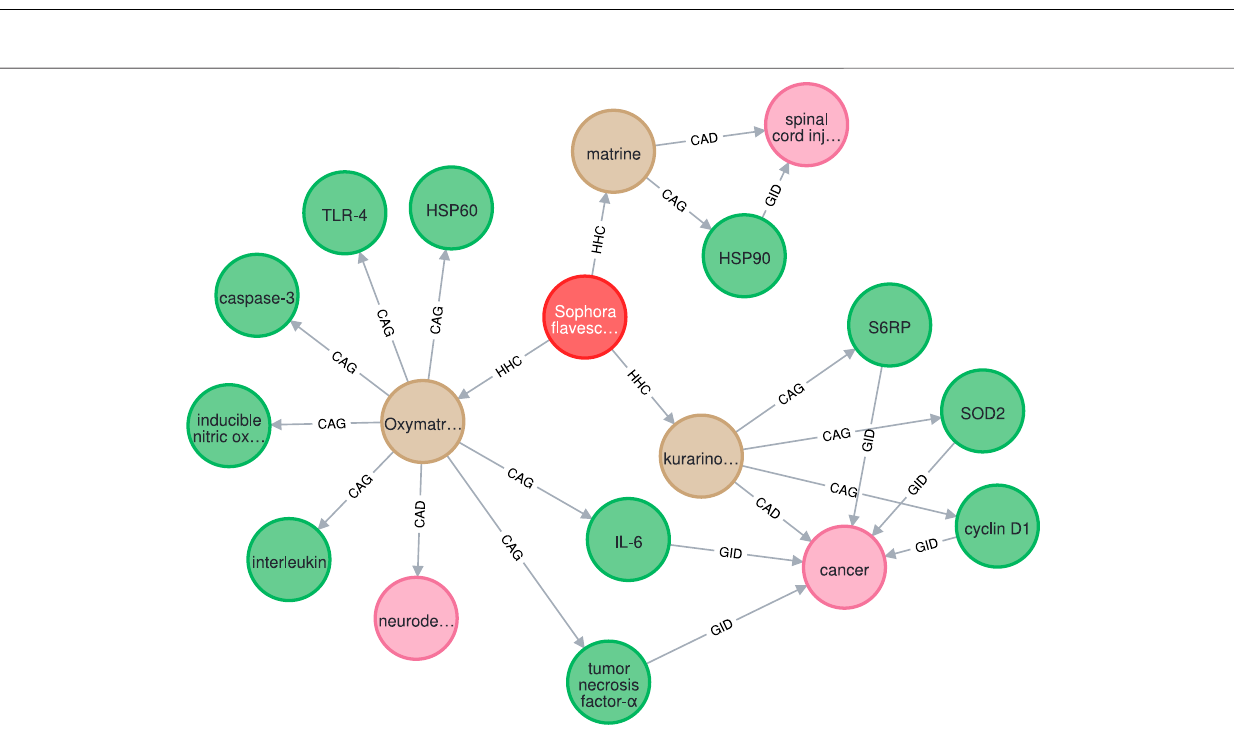
FIGURE 9 | An examination of token importance in the determination of a relation type. The example shows in the fi gure is correctly classi fi ed by the BioBERT- based RE model, which outputs a triplet ( “ cassia bark ” , “ cinnamaldehyde ” , “ HHC ” ) as an entry in the HerbKG.